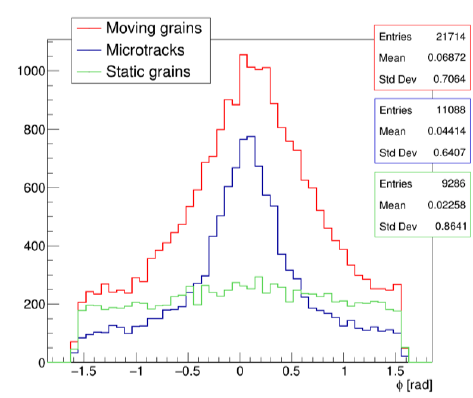
Figure 2. Angular distribution of single grains and